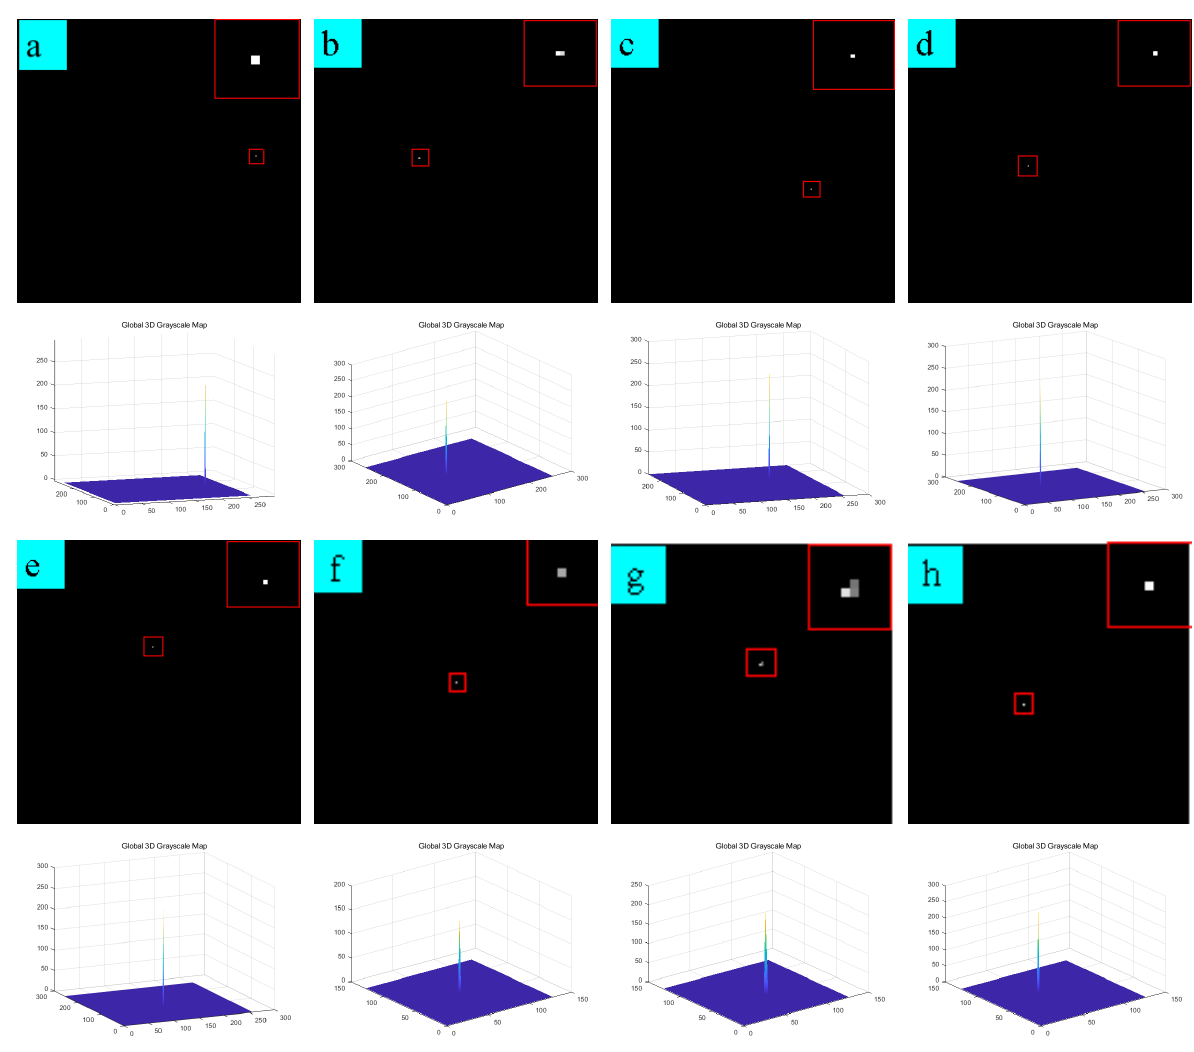
Figure 6. ( a – p ) Sixteen different infrared dim and small target scenes.